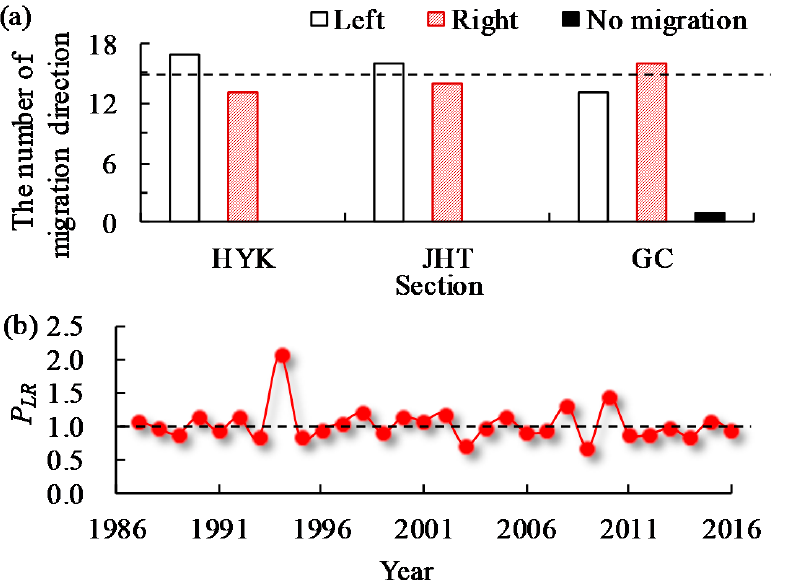
Figure 9. Variations in the section- and reach-scale centerline migration direction: ( a ) the number of each migration direction at typical sections; ( b ) reach-scale migration probability (PLR).